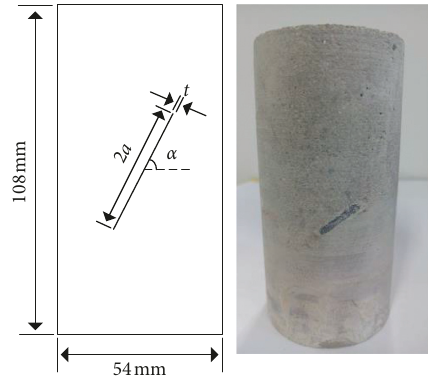
Figure 1: Geometry of the flaw in the rock-like